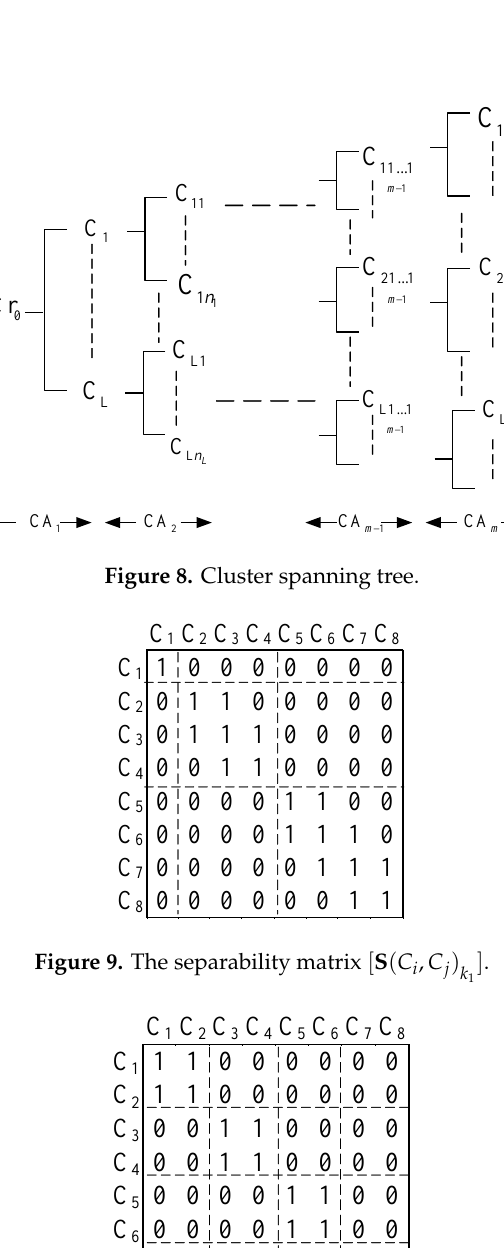
Figure 9. The separability matrix ]),([ Figure 10. Separability matrix . Figure 10. Separability matrix [ S ( C i , C j ) k Figure 10. Separability matrix